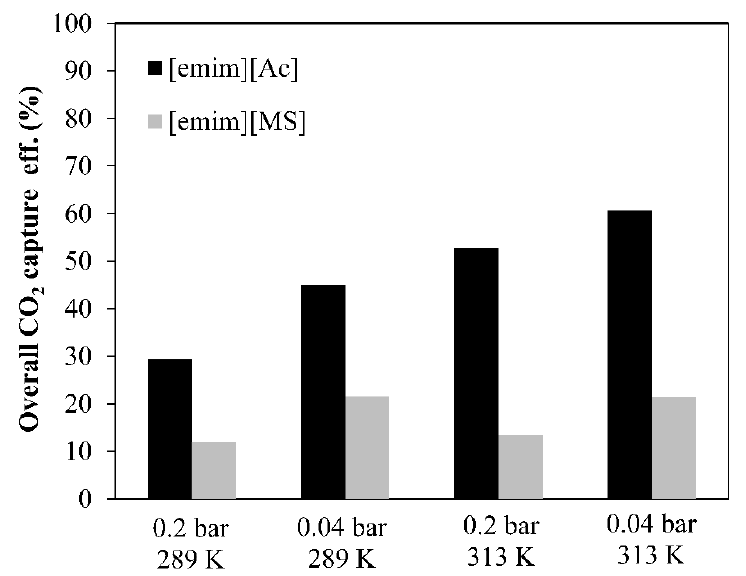
Figure 8. Overall CO 2 capture performance by using 2 ILs at different vacuum pressures and tem- peratures. Commercial HFMC operational conditions: liquid flow rate 60 mL·min-1. temperatures. Commercial HFMC operational conditions: liquid flow rate 60 mL · min − 1